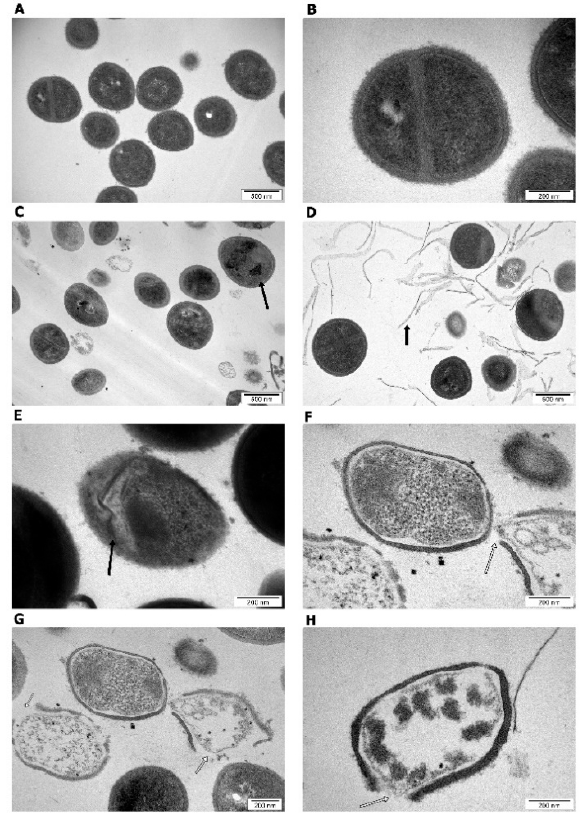
Figure 10. Morphology of S. aureus after PG and GO treatment. Transmission electron microscopy. ( A , B ) Control group; ( C , F ) PG-treated group; ( D , E , G , H ) GO-treated group. Black arrows indicate graphene agglomerates. White arrows indicate cell damage.